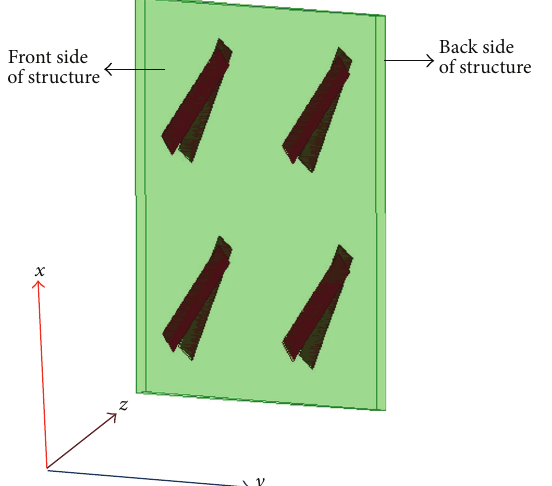
Figure 3: The figure presents the multiband circular polarizer based on 2 × 2 periodic metallic strips